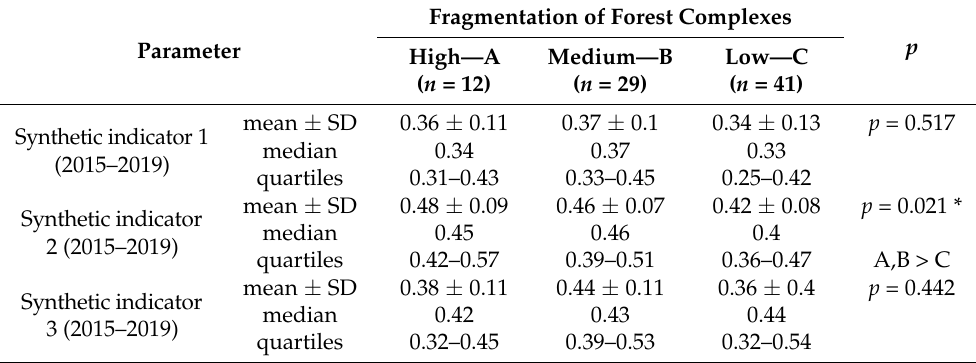
Table 8. Relationships between the synthetic indicators and forest district categories distinguished on the basis of the fragmentation of forest complexes.